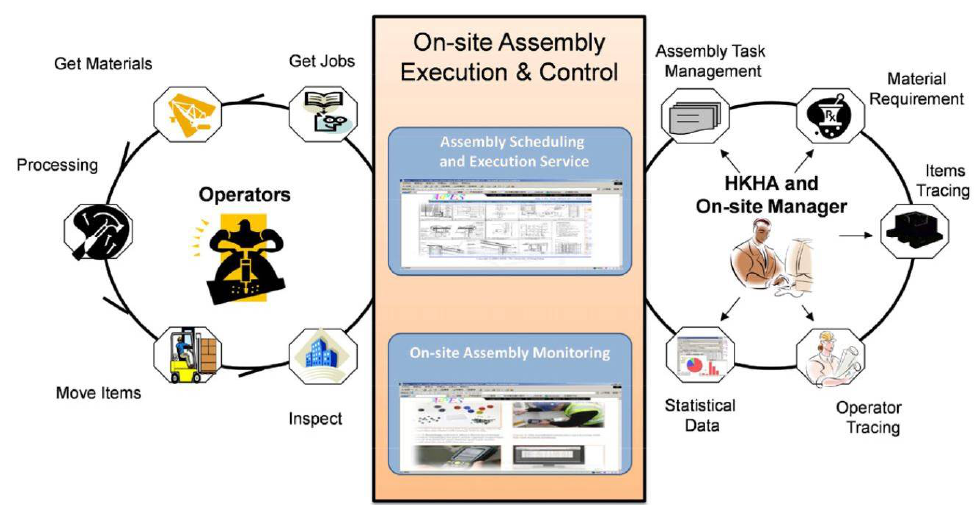
Figure 5. Execution and control during onsite installation. Reprinted with permission from Reference [35]. Copyright 2017 Copyright Elsevier B.V. Table 2. Condition analysis of prefabricated module fabrication